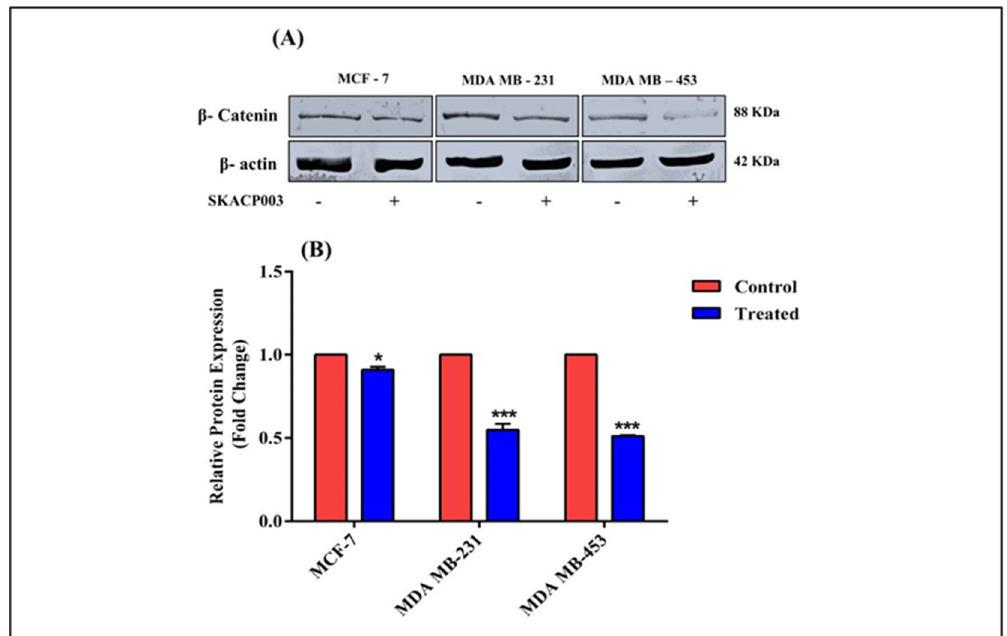
Figure 6. ( A ) Western blot analysis of β‐ catenin and control protein. ( B ) A bar chart displaying the level of β‐ catenin protein control and treated breast cancer cell lines. * = statistical significance at p < 0.05; *** = statistical significance at p < 0.001; ns = not significant